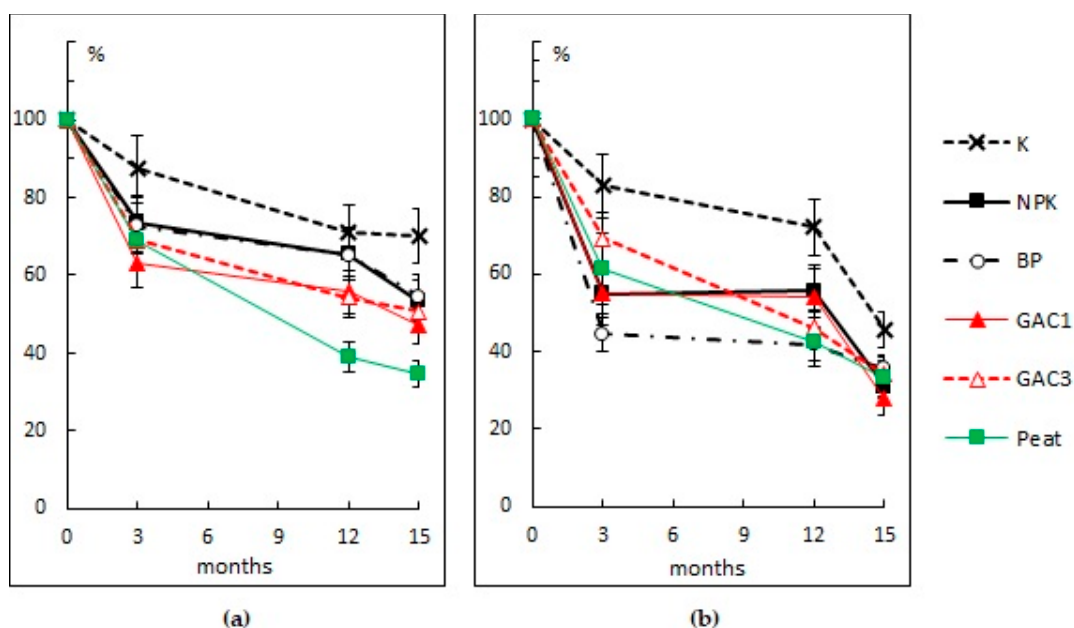
Figure 3. The dynamic of the TPH content ( a ) and high-molecular polar organic compounds ( b ) in the contaminated soil with different methods of bioremediation.